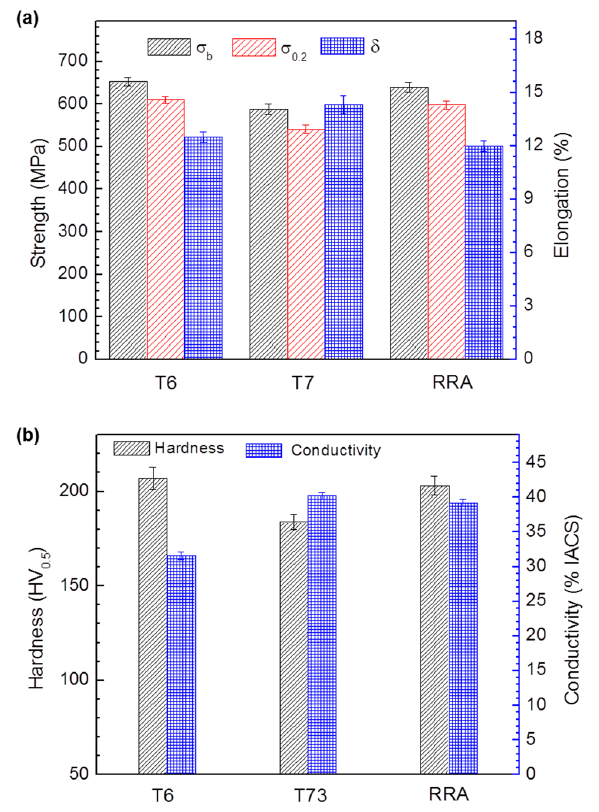
Figure 8. The mechanical properties and conductivity of the Ce-containing alloy at T6T7 and RRA temper: ( a ) tensile properties; ( b ) micro hardness and conductivity.